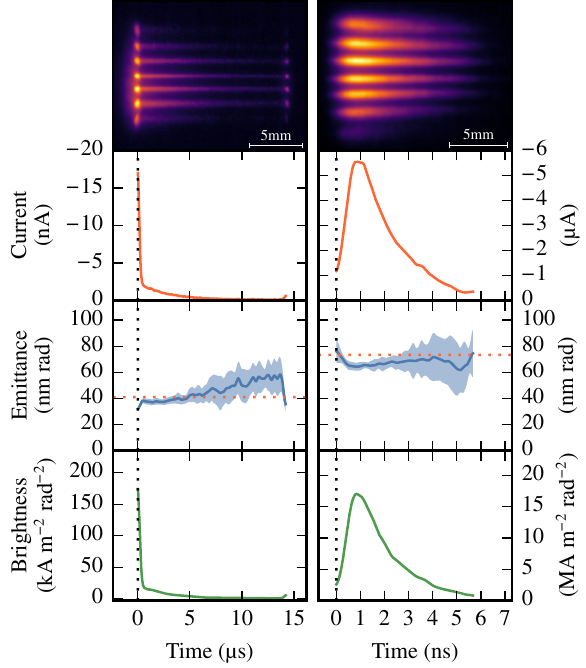
FIG. 3. Long (left) and short (right) duration streaked one- dimensional pepperpot measurements. From top to bottom: the false-color 1000-shot average streak image, the full beam current, the normalized RMS emittance of the beam with the shaded region indicating the standard deviation of ten 100-shot sub- averages, and the normalized brightness of the beam. The dotted black line indicates the start of the electron bunch and the dotted red lines on the emittance measurements indicate the expected emittance from the simulations shown in Fig.